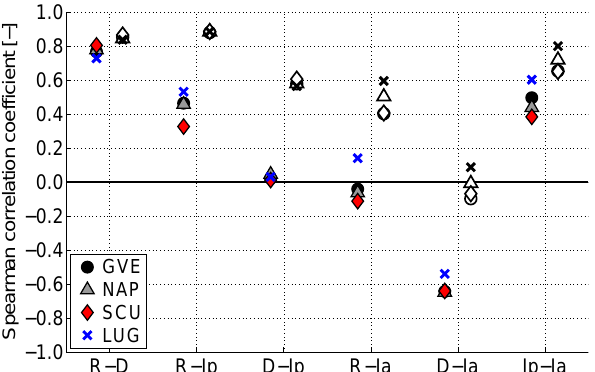
Fig. 11. Spearman rank correlation coefficients between pairs of main storm properties (storm duration D , total rainfall depth R , peak intensity I p and average storm intensity I a ) for intense warm season storms (filled, color markers) and all storms (empty markers) at the studied